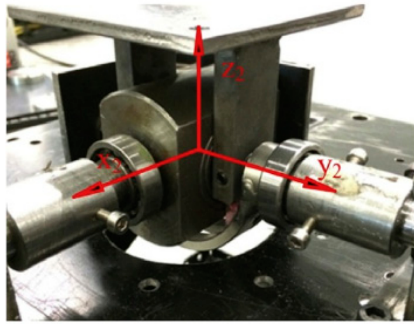
Figure 19. The geometry of universal joint [53].